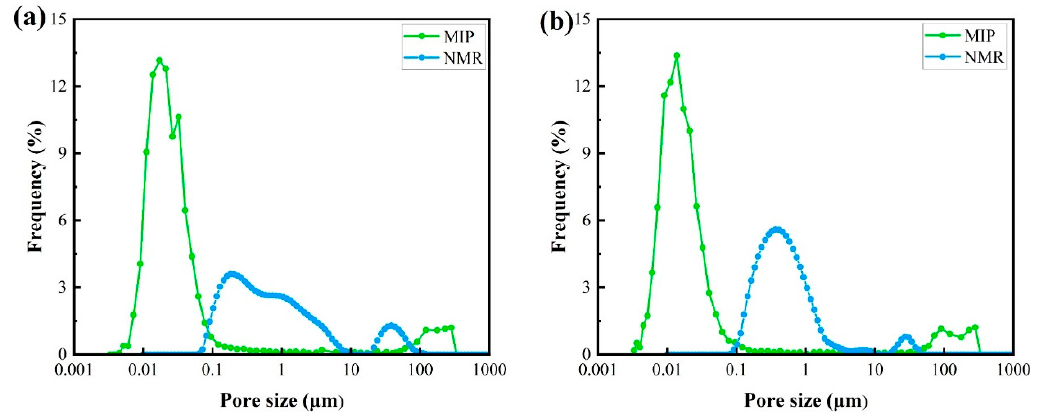
Figure 8. The pore size distribution was measured using nuclear magnetic resonance (NMR) and Figure 8. Pore size distribution was measured using nuclear magnetic resonance (NMR) and mercury intrusion porosimetry (MIP) of welded tuffs. ( a ) The strongly welded tuff. ( b ) The weakly welded mercury intrusion porosimetry (MIP) of the welded tuffs: ( a ) strongly welded tuff; ( b ) weakly welded tuff. tuff.